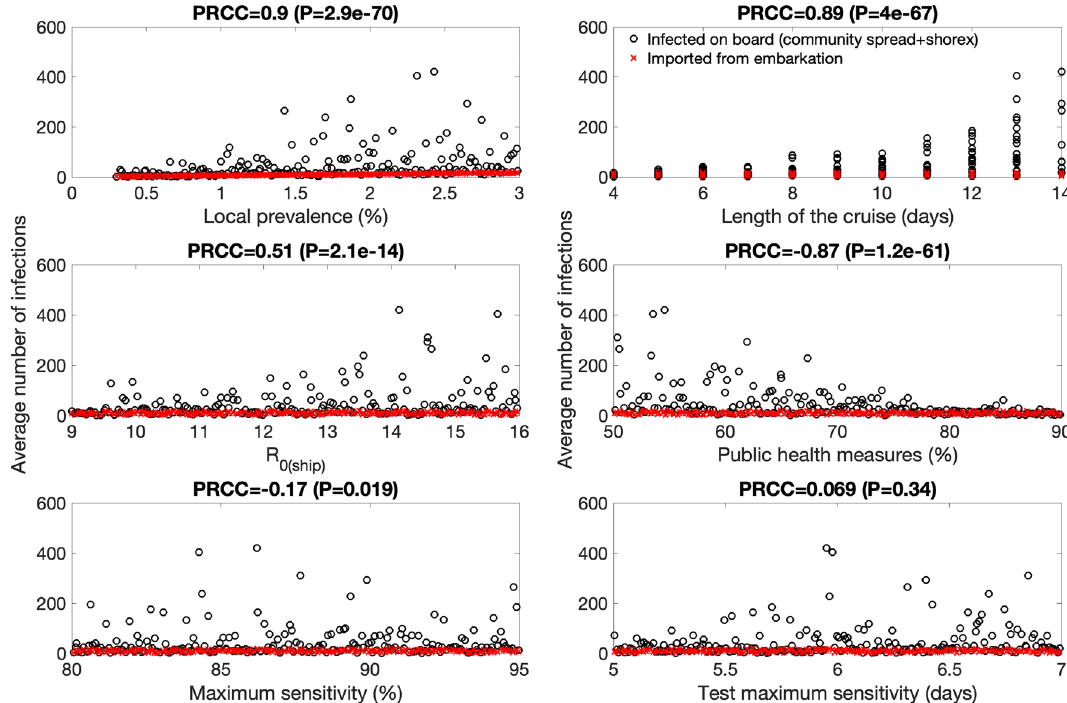
Figure 8. These scatter plots display the relationship between the model parameters and the average number of infections in the context of embarkation testing and public health measures. Partial rank correlation coefficients (PRCC) and their statistical significance (P value) after considering the uncertainty ranges for each parameter (Table 1) are also shown. Local prevalence, the extent of public health measures and the length of the cruise are highly and positively correlated with the expected number of cases at the end of the simulations. The basic reproduction number aboard the ship is only weakly correlated with the average number of